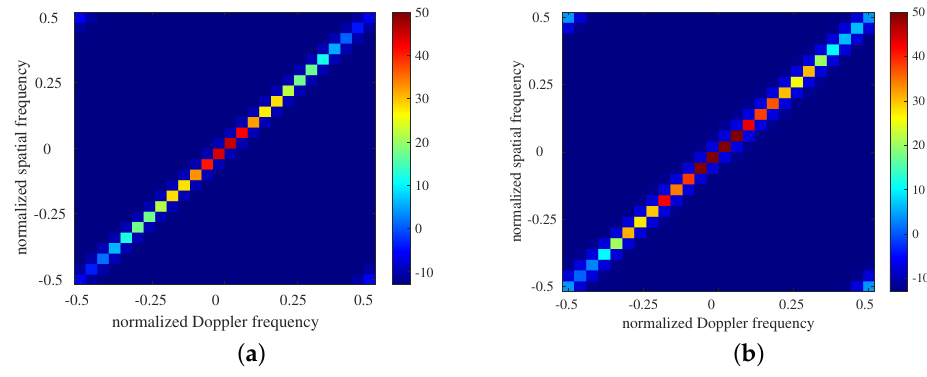
Figure 4. CNR versus range cell of D test .